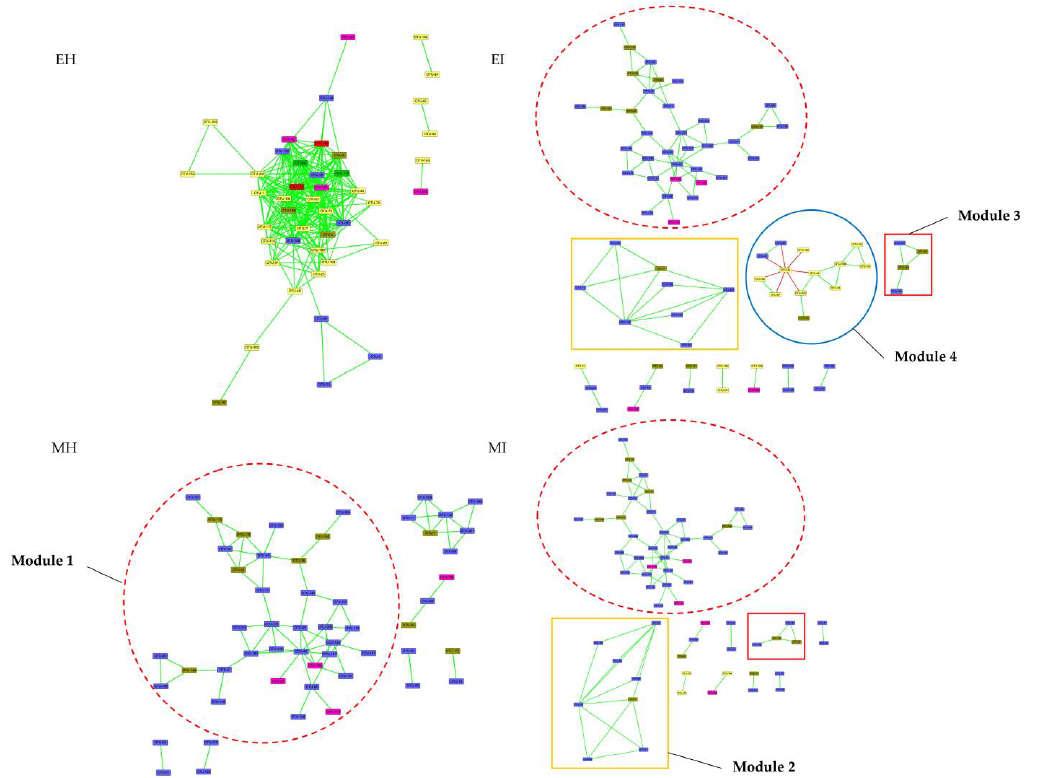
Figure 8. Phylogenetic co-occurrence networks of intestinal bacterial microbiota in four groups. The networks were constructed at the OTU level. The edge color represents positive (green) and negative (red) correlations. The edge thickness indicates the correlation values, and only the high-confidence interactions with absolute sparse correlations greater than 0.55 were selected. (EH: emergence period, healthy; EI: emergence period, infested; MH: mating period, healthy; MI: mating period, infested).